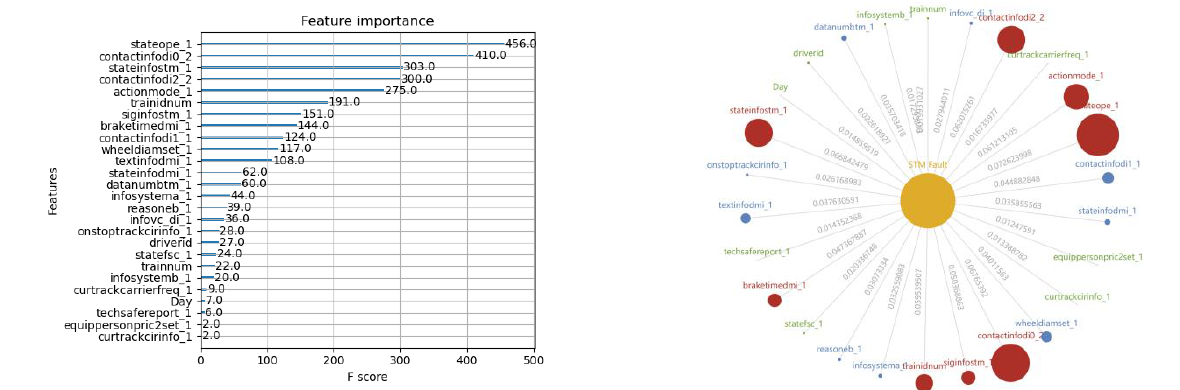
Figure 8. Results of XGBoost training using CGAN-enhanced 2018-T(A) sample set.